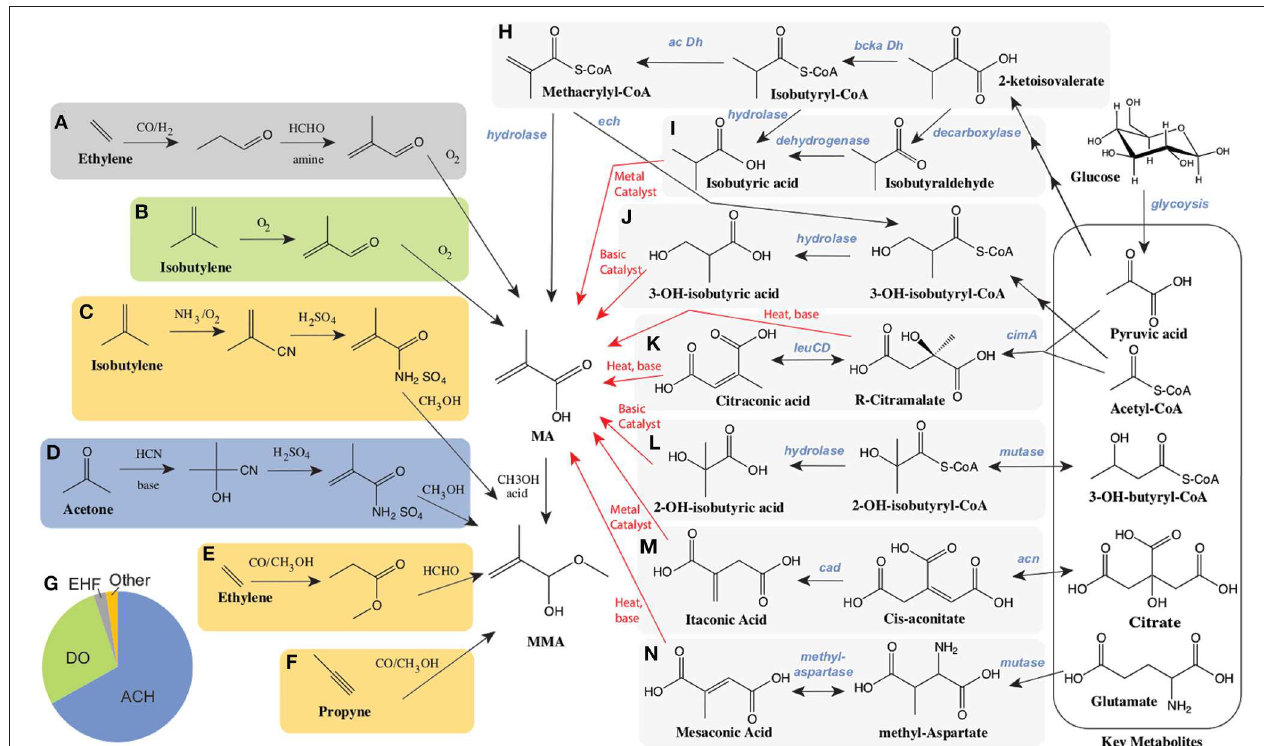
FIGURE 1 | Current petrochemical routes and proposed bioprocessing alternatives for the manufacture of MA/MMA. Petrochemical routes (A–G) . The C2 manufacturing routes of MA using ethylene as starting material include (A) BASF’s ethylene hydroformylation (EHF) to propionaldehyde followed by condensation to methacrolein before oxidation and esterification to MMA and (E) the Alpha process where ethylene is converted to MMA via methyl propionate. The C3 routes include: (D) the Acetone Cyanohydrin (ACH) process starting from acetone and hydrogen cyanohydrin, and (F) the propyne route with the carbonylation and esterification of methyl acetylene. The C4 routes, starting from isobutylene include (B) , Direct Oxidation (DO) process and (C) Asahi’s process reliant on ammonia. (G) The global breakdown of MMA supply by process technology. Alternative biological routes to produce MA from sugars such as glucose (H–N) . Bioconversion steps and chemical conversions are shown as black and red arrows respectively. (H) Direct biosynthesis of MA through the intermediates keto-isovalerate, isobutyryl-CoA and methacrylyl-CoA reliant on a branched chain keto-acid dehydrogenase (bcka Dh) and an acyl-CoA dehydrogenase (ac Dh). (I) Production of isobutyrate either from keto-isovalerate through isobutyraldehyde, or alternatively through isobutyryl-CoA. (J) The conversion of methacrylyl-CoA to 3-hydroxy-isobutyrate (3HIBA) is reliant on an enoyl-CoA hydratase (ech). Citramalate is produced from acetyl-CoA and pyruvate via a citramalate synthase ( cimA ) and can then be converted to citraconate via isopropylmalate isomerase such as encoded by the leuCD genes. Both citramalate and citraconate can be converted chemically to MA. (L) 2-hydroxy-isobutyrate (2HIBA) can be produced from 3-hydroxybutyryl-CoA through a mutase and hydrolase. (M) Itaconic acid is derived from citric acid through the intermediate cis-aconitate via two enzymes: aconitase (acn) and cis-aconitate decarboxylase (cad). (N) Mesaconic acid is synthesized from glutamate through methyl-aspartate using a mutase and